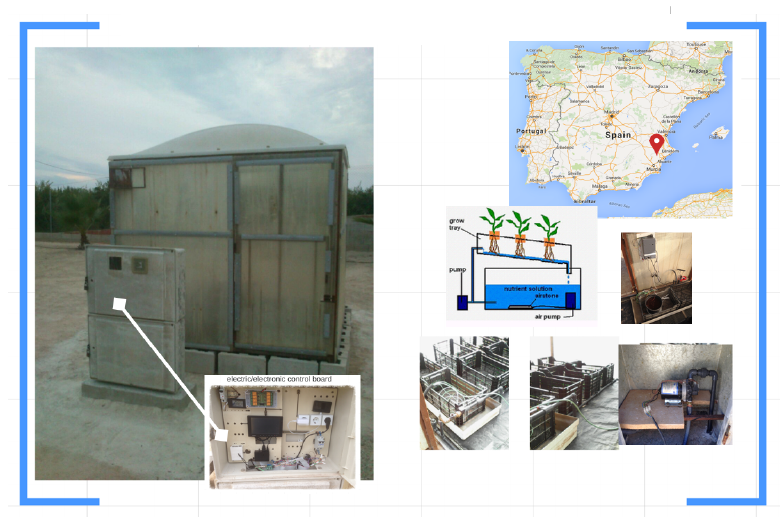
Figure 7. Experimental Hydroponic Station. Hydroponic crop in greenhouse. Localization and different